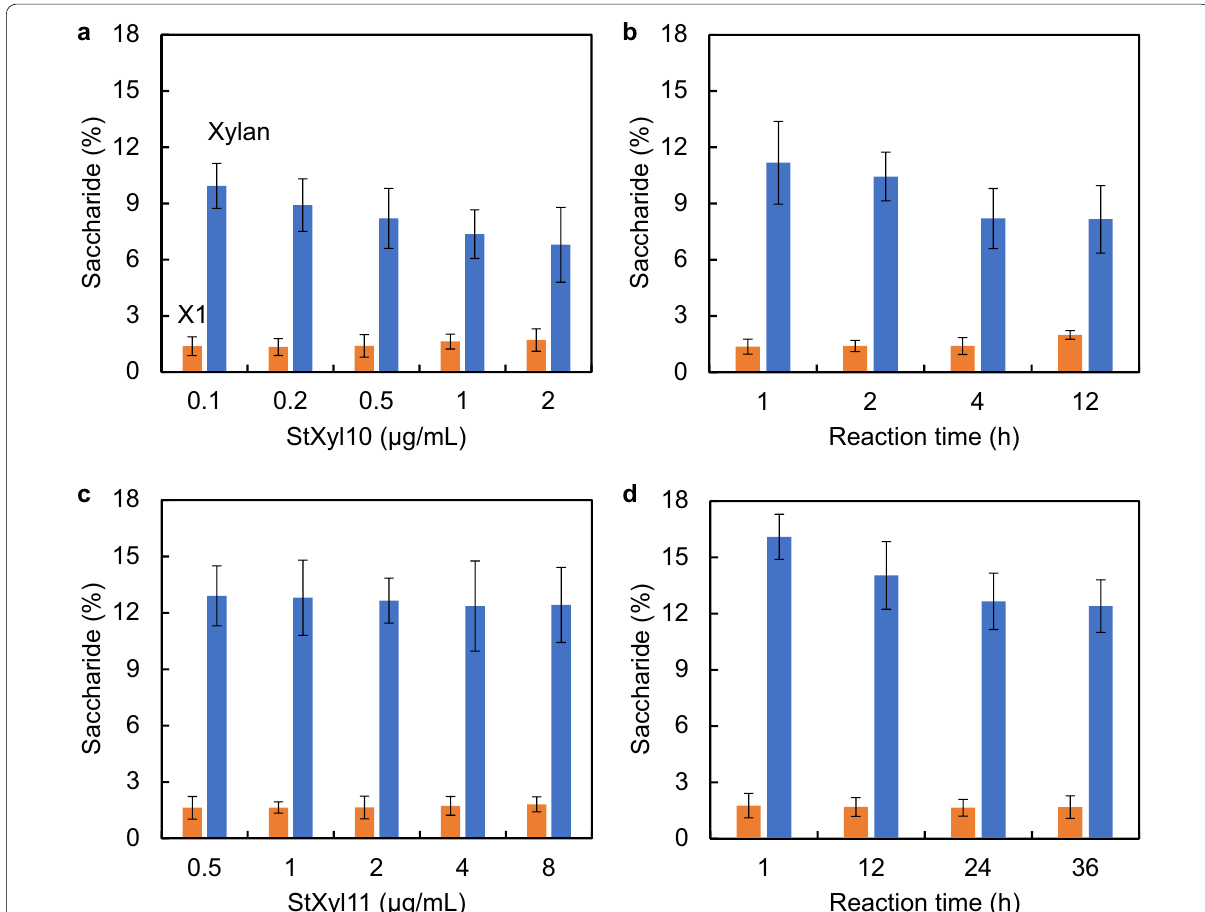
Fig. 4 Hydrolysis of DX by StXyl10 and StXyl11. The hydrolysis products were developed by TLC, and the densities of X1 and DX were evaluated by ImageJ. The amounts of X1 and DX under hydrolysis conditions (0.5 μg/mL StXyl10 for 4 h and 2.0 μg/mL StXyl11 for 24 h) were determined by a d -xylose analysis kit and gel filtration, respectively. The amounts of X1 and DX under the other conditions were obtained by TLC densities. a DX was hydrolyzed by 0.1–2.0 μg/mL StXyl10 for 4 h at 50 °C and pH 6.5. b DX was hydrolyzed by 0.5 μg/mL StXyl10 for 1–12 h at 50 °C and pH 6.5. c DX was hydrolyzed by 0.5–8.0 μg/mL StXyl11 for 24 h at 60 °C and pH 6.5. d DX was hydrolyzed by 2.0 μg/mL StXyl11 for 1–36 h at 60 °C and pH